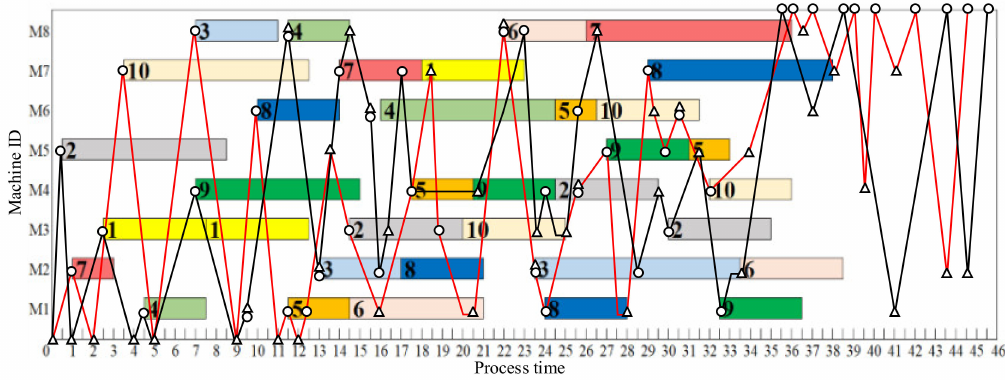
Figure 3. FJSP Gantt chart with 2